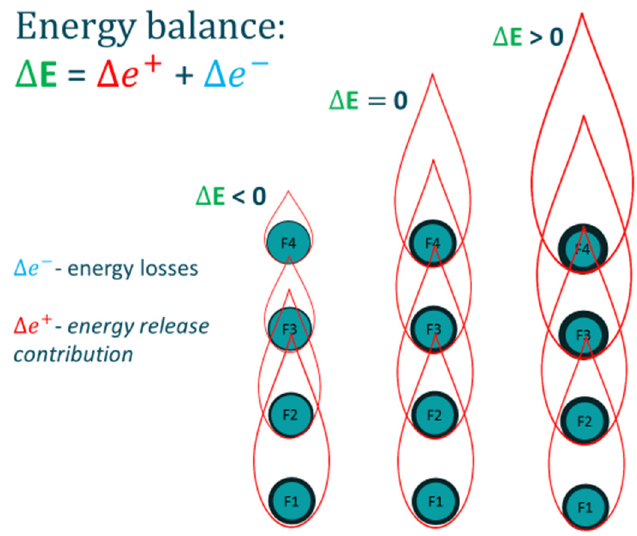
Figure 7. The figure shows the energy balance and the state of the frontal flame determined by the energy balance at each separate fuel element ( ∆E ), which is the sum of energy generation ( ∆ e + ) and energy losses ( ∆ e − ). Flame propagates from fuel element F1 to fuel element F4; flame from each previous element represents incoming frontal flame. Vertical direction of flame propagation, from the bottom to the top (instead of tilted sideways-upward as in real crown fire flame-fronts) represents the experimental setup and the apparatus. Depending on the weather conditions, and the physical, chemical, and spatial properties of the particular fuel bed, the value of ∆ e + may or may not be sufficient to compensate for the energy losses from a fuel element ∆ e − to the environment and into the horizontal propagation flux for preheating the next fuel elements. The frontal flame propagates steadily (middle image, equilibrium state) when ∆ e + = | ∆ e − | because the horizontal propagation flux for the preheating of the next fuel elements (which is the “useful” part of ∆ e − ) is compensated by the sufficient part of energy generation ∆ e + . The frontal flame declines (left image) if ∆ e + < | ∆ e − | because lower values of ∆ e + relative to | ∆ e − | indicate declines in the horizontal propagation flux for the preheating of the next fuel elements, which is now insufficiently compensated by ∆ e + . The frontal flame grows (right image) when ∆ e + > | ∆ e − | because higher values of ∆ e + relative to | ∆ e − | indicate increases in the horizontal propagation flux for the preheating of the next fuel elements.